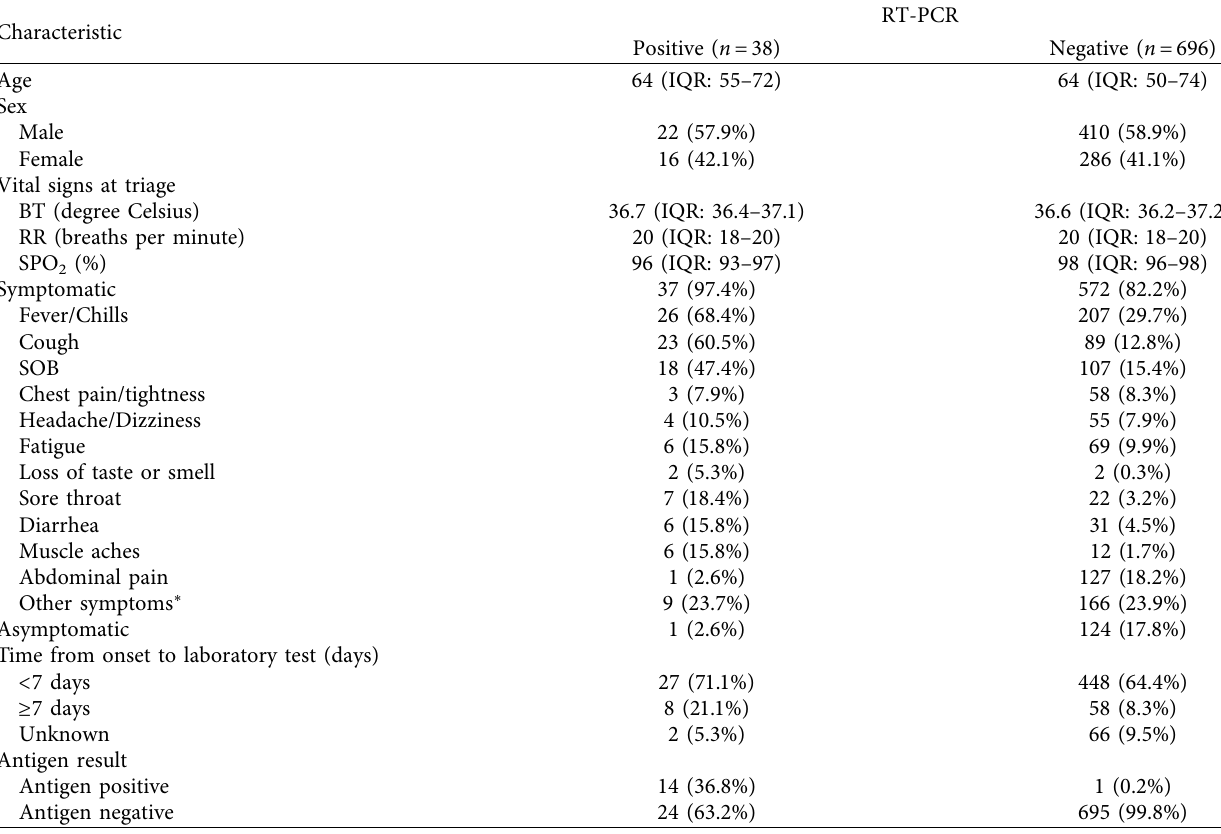
Table 2: Characteristics and antigen result of patients in the ED.